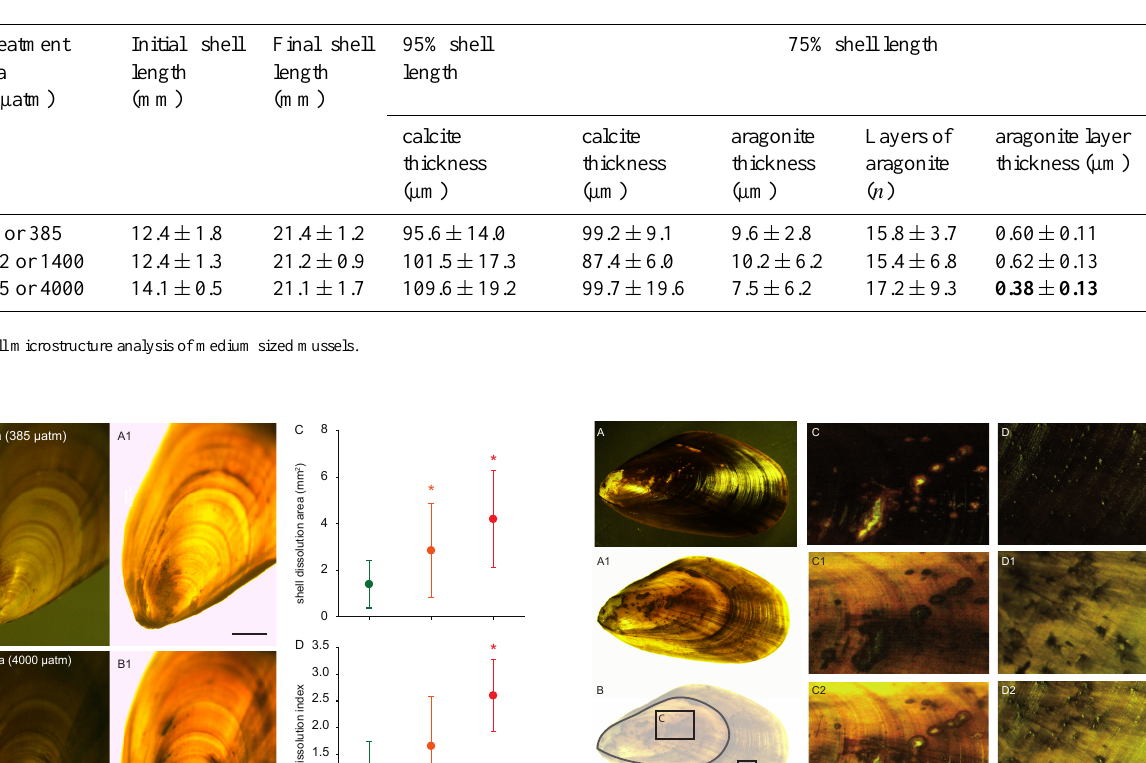
Table 4. Shell microstructure analysis using SEM. N = 5 mussels of similar final length (medium size) were cross sectioned at 75 and 95% shell length. Mean values ± SD, significant differences from control (39Pa, 385µatm) in bold. Both cross sections are located in parts of the shell that have been newly formed during the experimental incubation.